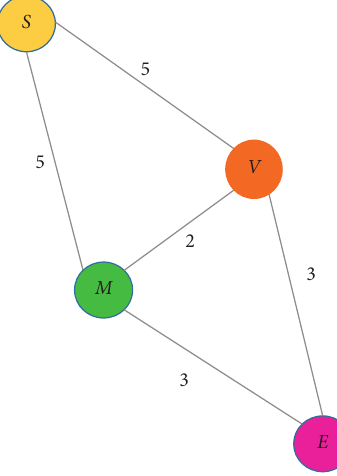
Figure 7: Undirected network graph 3. Figure 8: Undirected network graph